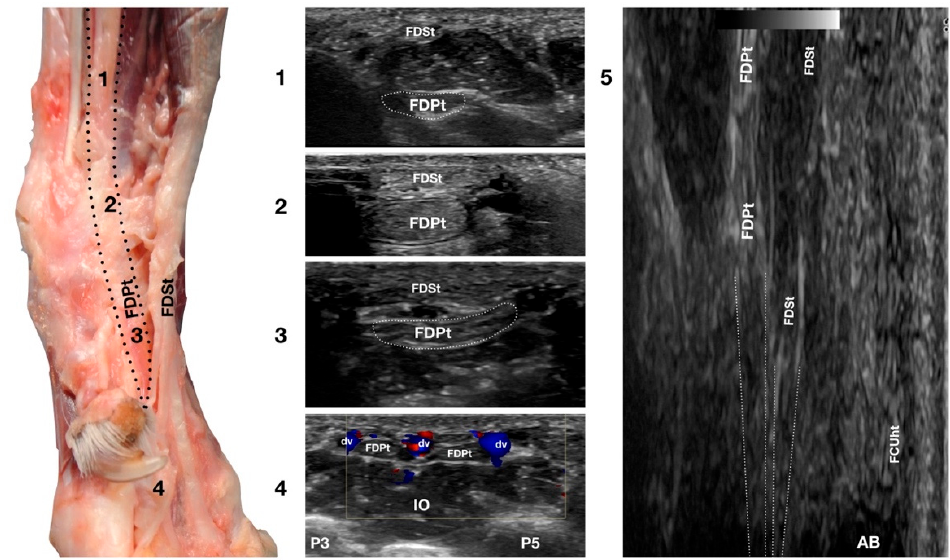
Figure 8. Palmaromedial carpal face centered on the Flexor Digitorum Profundus tendon. The FDSt were displaced to show the FDPt beneath. At the ulnar notch level (2), the FDPt is a wide, thick, oval structure, surrounded by ill-defined echoic tissue (the Retinaculum ). It is just a little deeper but is in close contact with the thinner Flexor Digitorum Superficialis tendon. Proximally, at the tenomuscular junction (1), the tendon is located in a deep position. It runs obliquely distally, becoming progressively more superficial until the level of the radial notch where it pairs with the FDSt (2). At the level of the proximal third of the metacarpus, the tendon becomes thinner and wider (3) until it starts to divide into four parts that diverge and follow the superficial and thinner parts of the FDSt (4). The thin tendons of the FDS and of the FDP are outlined by the small branches of the digital veins (dv). The thick interosseous muscles (IO) separate the tendons from the third (P3), fourth (P4), and fifth (P5) metacarpal bones. On the longitudinal scan (5) obtained by putting the probe in the hollow area medial to the accessory bone and angling the probe slightly medially, the fine fibrillar pattern of the FDPt is seen, converging toward the FDSt. The more superficial FCUt and the accessory bone (AC) are barely visible.